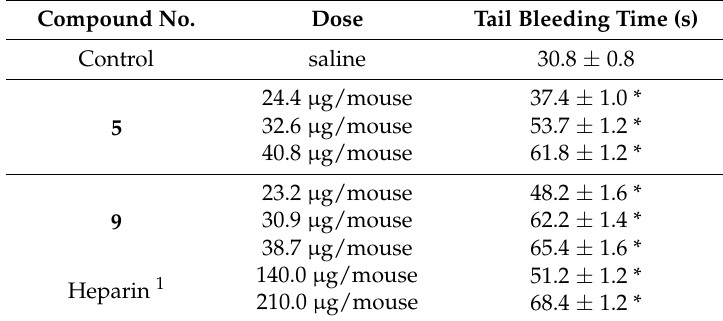
Table 3. In vivo Bleeding time of 5 and 9 .